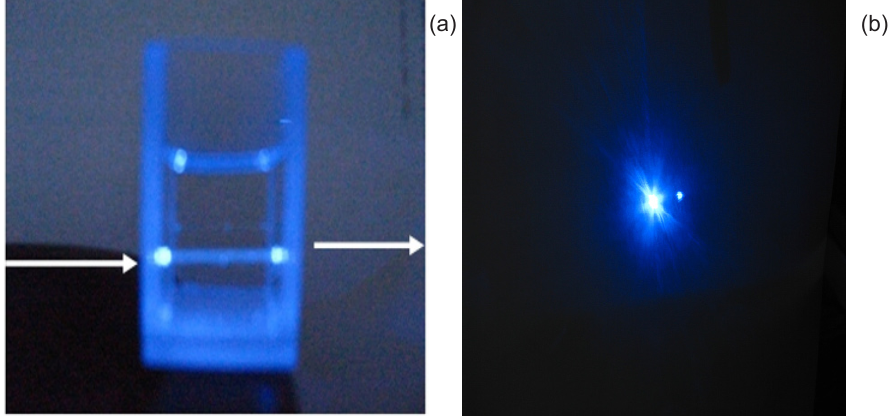
Figure 2. Flux of blue laser beam: a) through 0.1 mol L –1 Tl